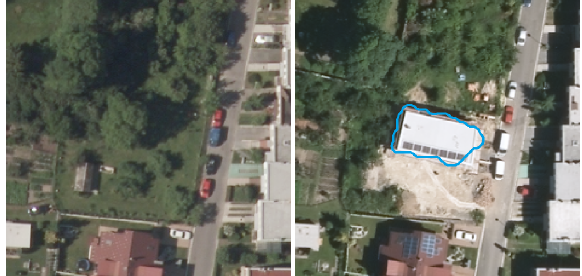
Figure 16. Left: aerial image (2010) Right: aerial image (2012) with an indication of a new building